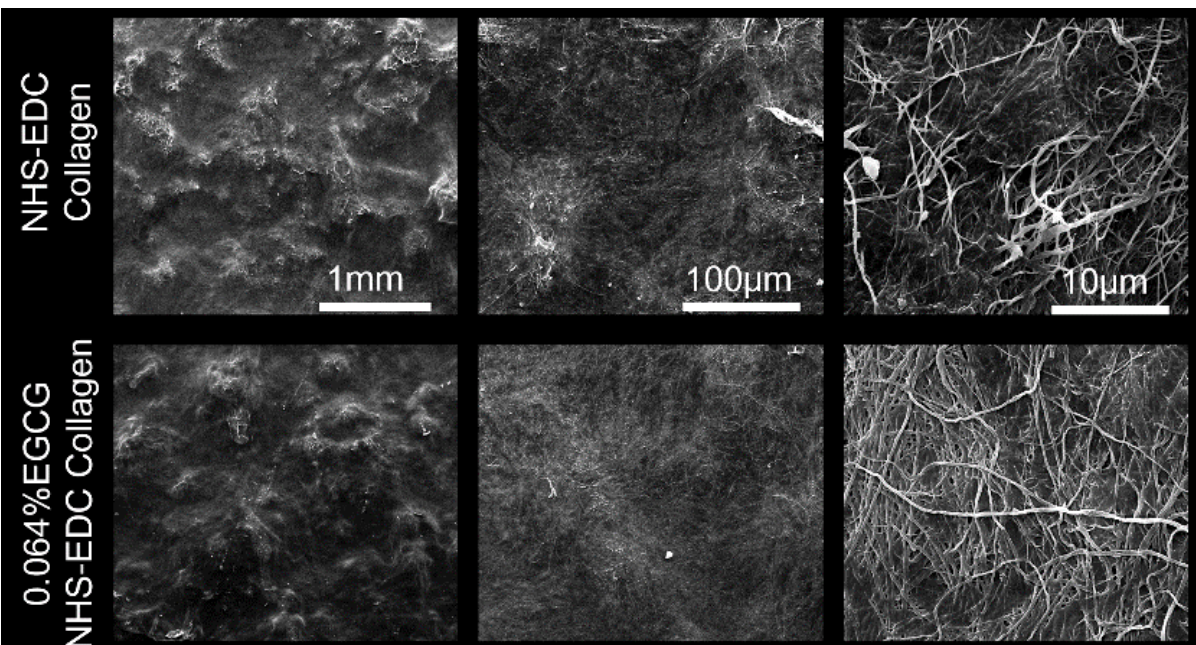
Figure 2. SEM images of EDC/NHS collagen membrane and 0.064% EGCG loaded EDC/NHS collagen membrane.